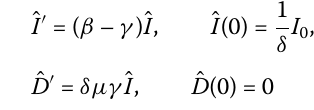
In Fig. 4 we show the relative sensitivities Σ C / C and Σ D / D for detection rates δ = 0.1,0.2 and 0.33. The chosen initial values are E 0 = 150 and I 0 = 100 (detected) cases at day 0. All other parameters resemble the assumed values for Germany. Note, that at the onset of the epidemics, i.e. in case of δ = 0.1 for t (cid:2) 30 and for δ = 0.2,0.33 even for t (cid:2) 40, the